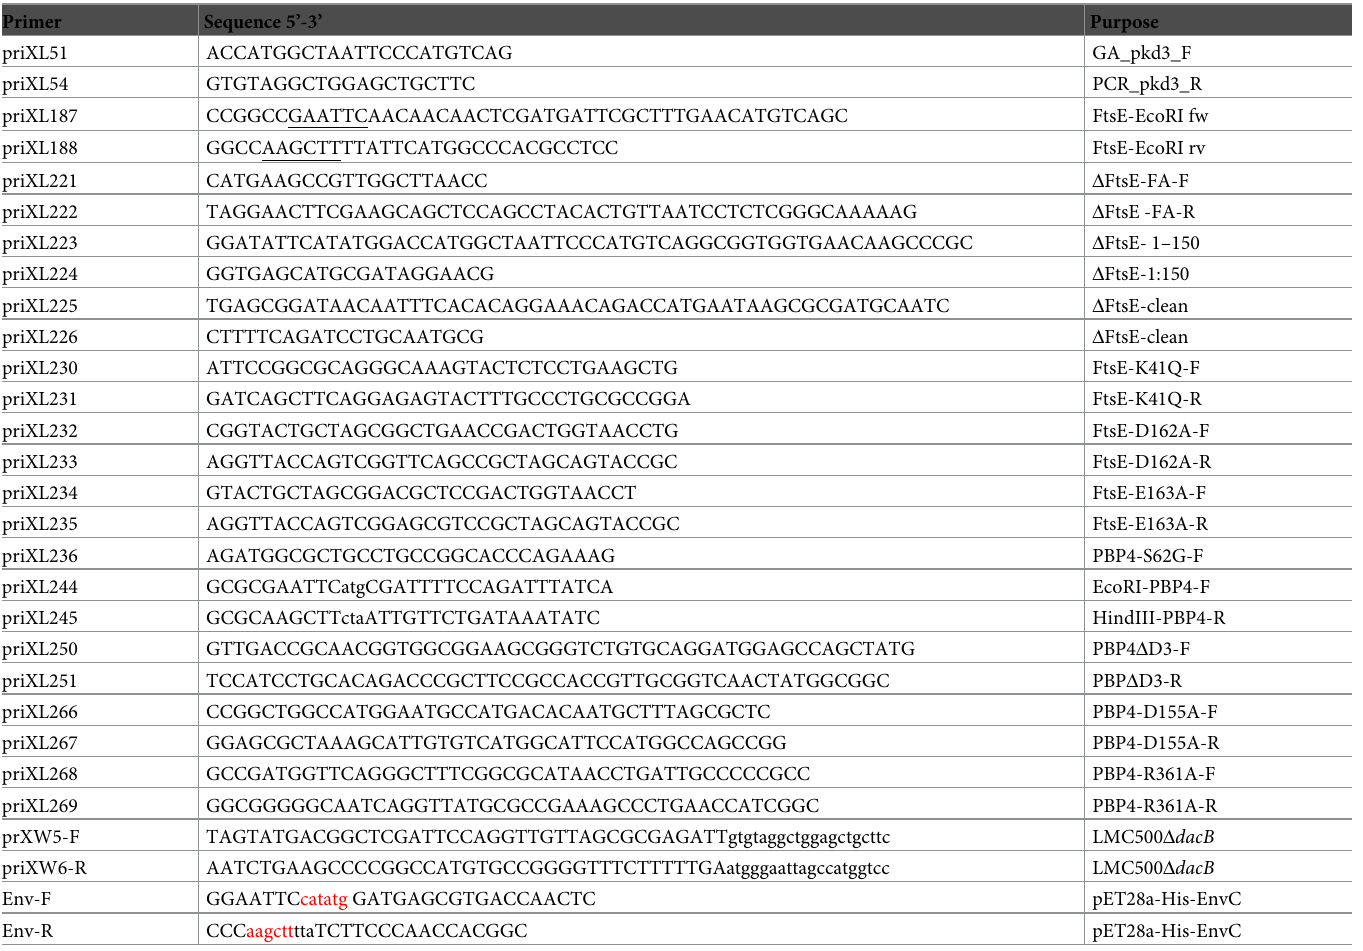
Table 2. Primers used in this